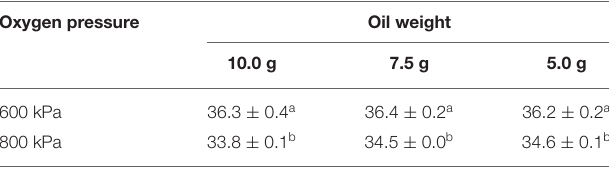
TABLE 3 | Induction periods (IPs) of 5, 7.5, and 10g of golden linseed oil determined by the OXITEST with oxygen pressures set to 600 and 800